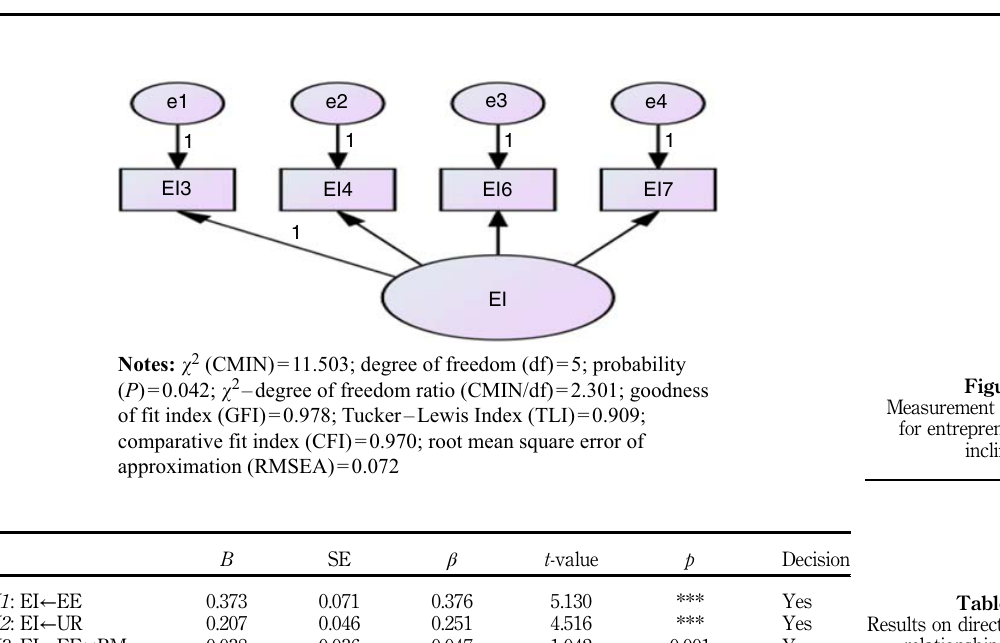
Table VI. Goodness-of-fit results for entrepreneurial inclination